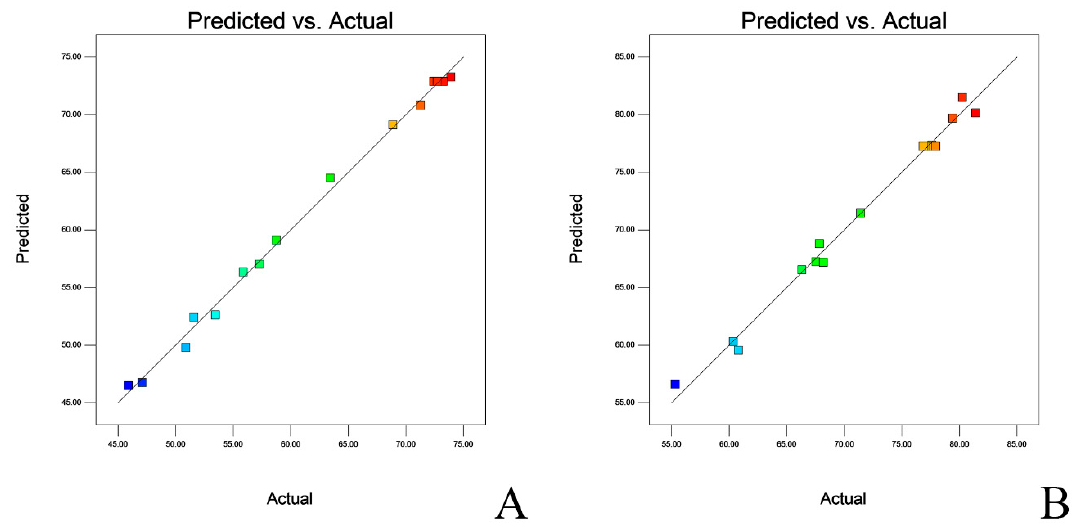
Figure 4. Linear plot fitting predicted vs. actual viability of lactobacilli. ( A ): L. salivarius . ( B ): L. agilis.